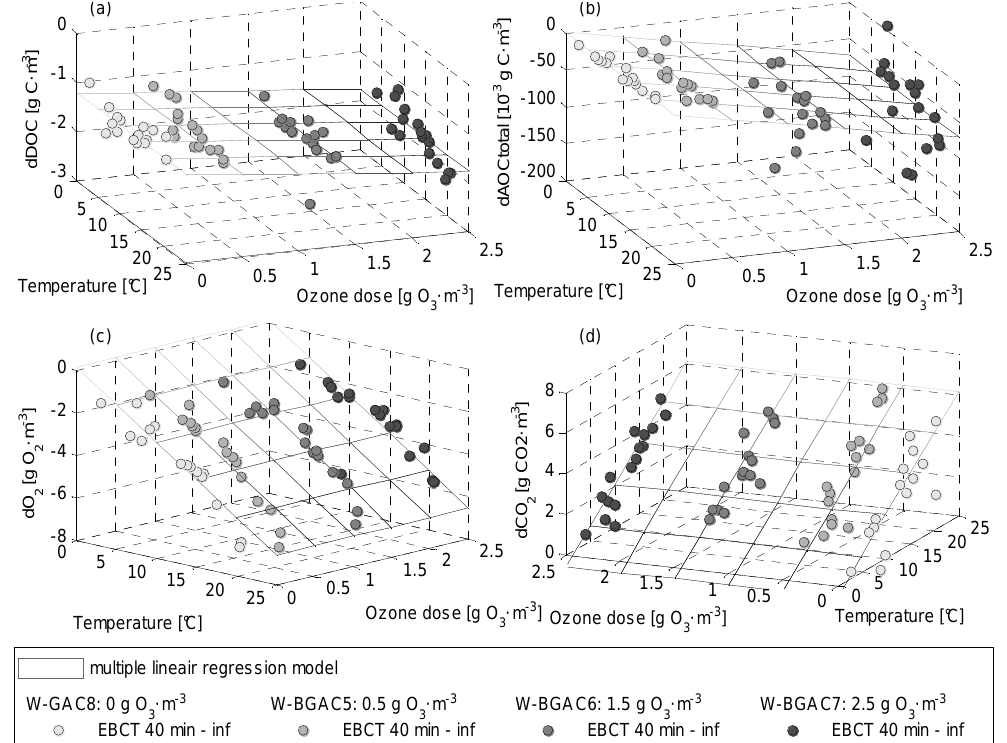
Figure 4. MLRs for biological conversions of DOC (a) , AOC (b) , oxygen (c) and carbon dioxide (d) as a function of the ozone dose and temperature from day 194 to 559 (set